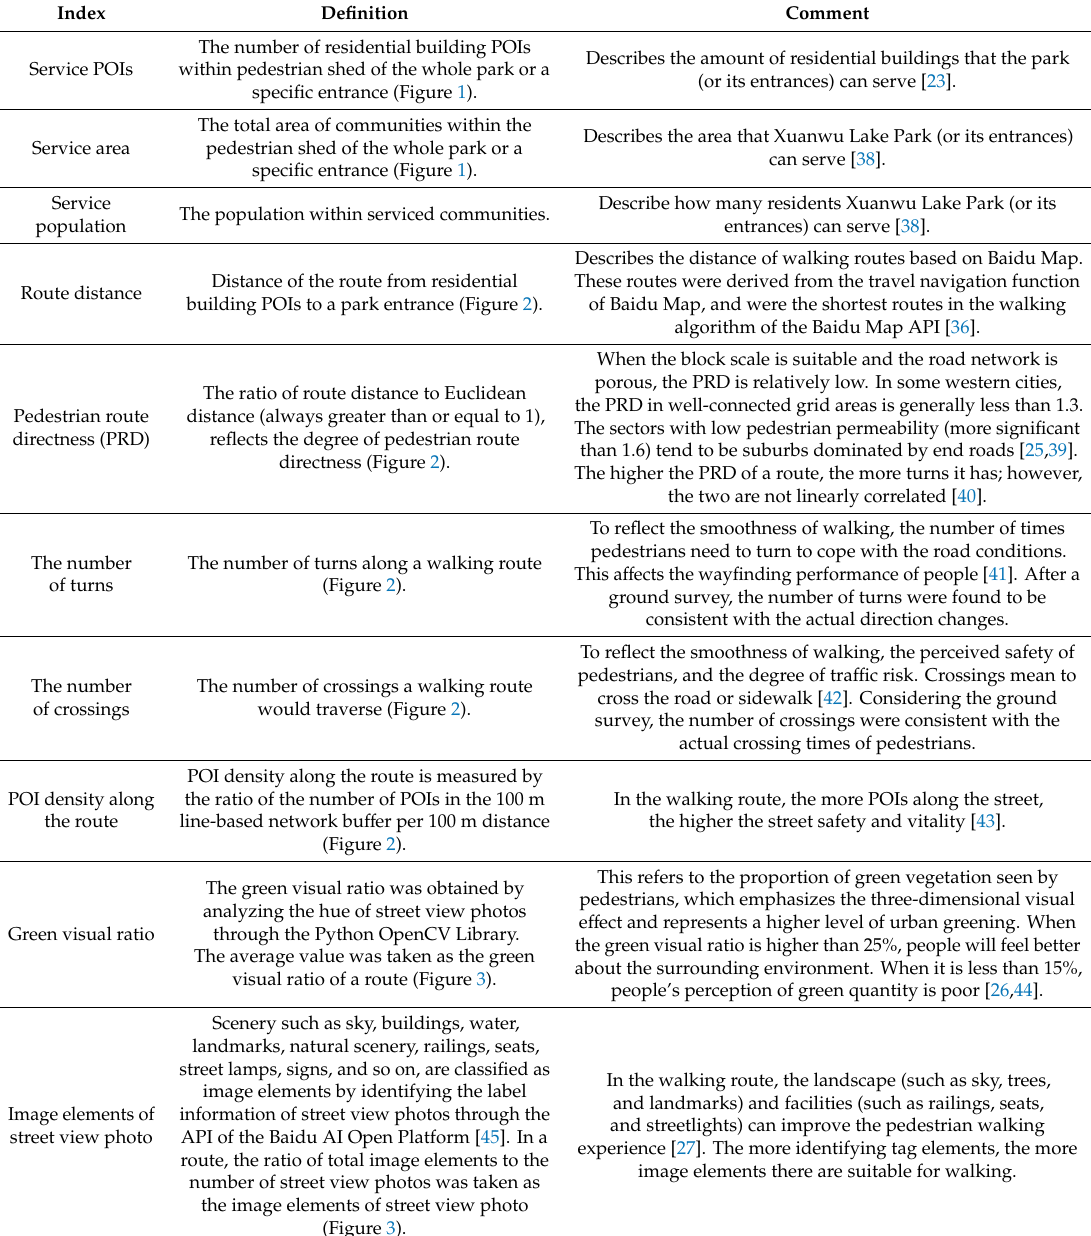
Table 1. Indices relevant to the walking routes to the